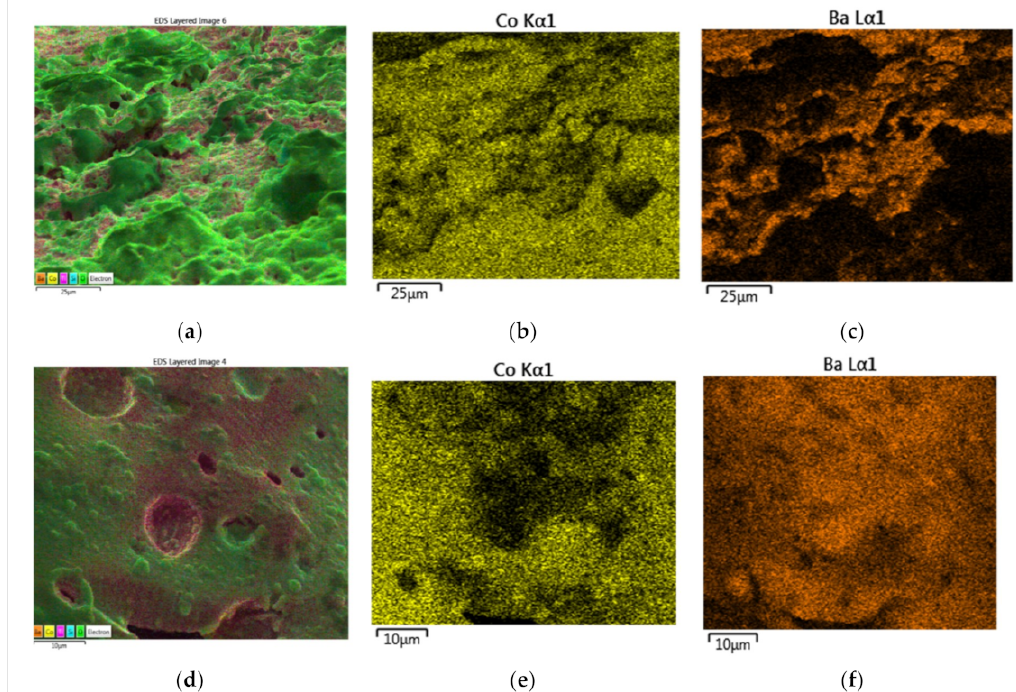
Figure 30. EDS images of two {Co / Si = 2} / BT = 1 / 4 composite catalysts showing the distribution of cobalt and barium as the markers for Co / Si = 2 and BaTiO 3 . ( a ) EDS image of mixed catalyst with Co / Si = 2 catalyst deposited on the surface of BaTiO 3 surface, occupying the spaces between BaTiO 3